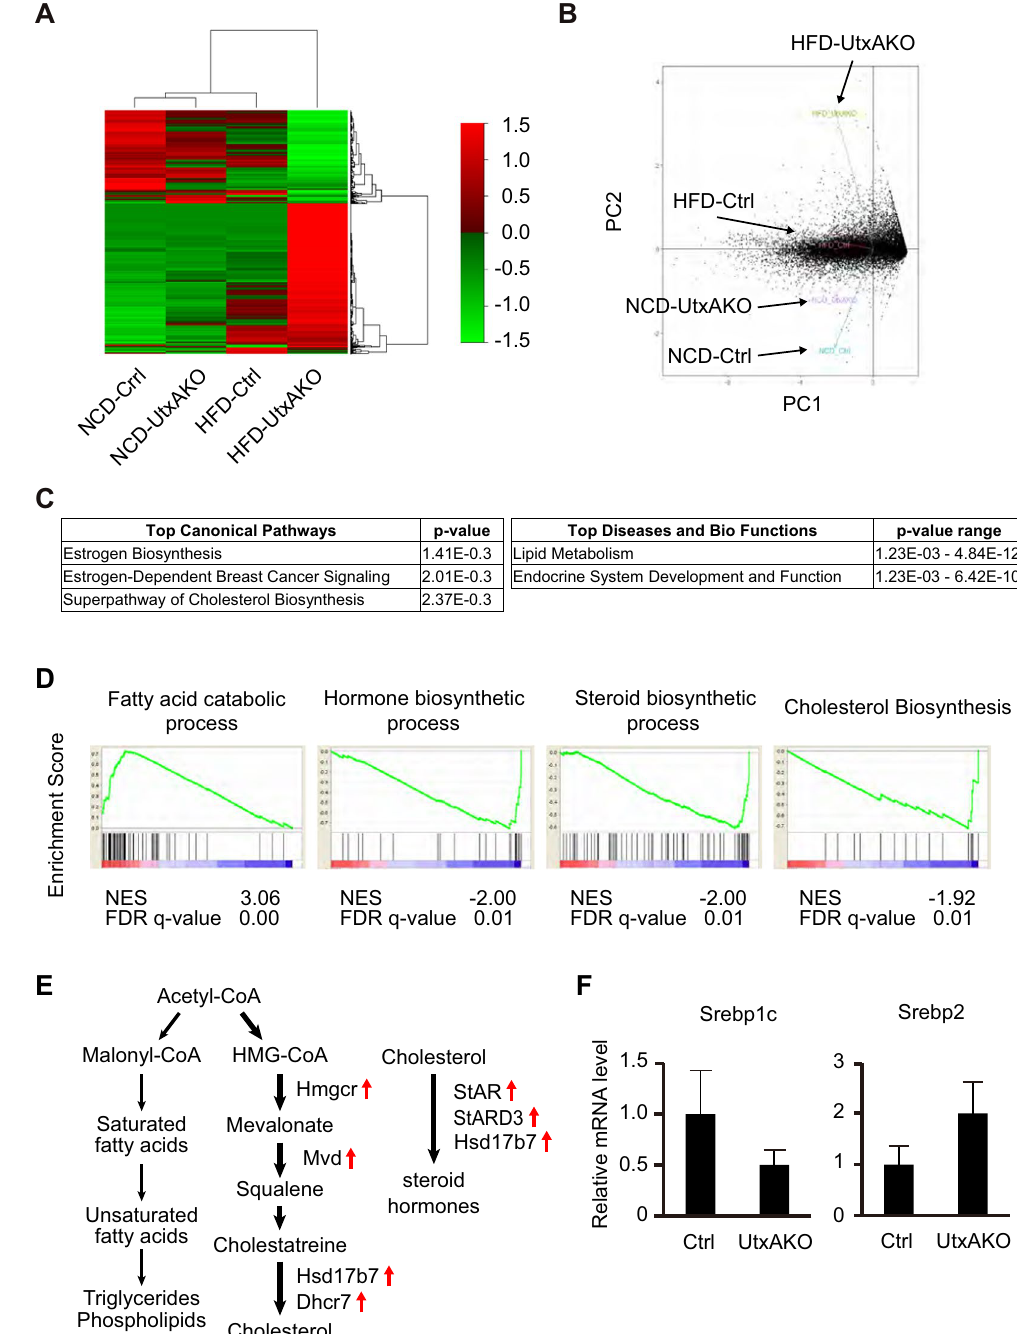
Figure 3. Utx deficiency represses triglyceride synthesis and induces cholesterol and estrogen synthesis. ( A ) Unsupervised clustering of gene expression patterns in visceral WAT of f-NCD-Ctrl, f-NCD-UtxKO, f-HFD- Ctrl and f-HFD-UtxAKO mice at 13 weeks, as indicated (n = 3). Right side: Corresponding heat map of barcode representation. Red and green correspond to high and low expression levels, respectively, compared with the experiment-wide median. The averages of each group with three mice were used for the clustering. ( B ) Principal component analysis (PCA) based on the gene expression profiles in visceral WAT of the mice in ( A ). ( C ) Identification of estrogen synthesis, estrogen signaling pathways and lipid metabolism among five top hits of Top Canonical Pathways and Top Diseases and Bio Functions in the f-HFD-UtxAKO mice by Ingenuity pathway analysis (IPA). The differentially expressed genes between f-HFD-Ctrl and f-HFD-UtxAKO with statistical significance were analyzed with IPA. Results are shown with p -values. ( D ) Identification of enhanced cholesterol/estrogen biosynthesis and decreased fatty acid synthesis in HFD-fed UtxAKO mice compared to HFD-fed Ctrl by Gene Set Enrichment Analysis (GSEA) at 13 weeks. The analysis examined isoforms that were expressed more than 0.3 FPKM (Fragments Per Kilobase of exon per Million mapped reads) in